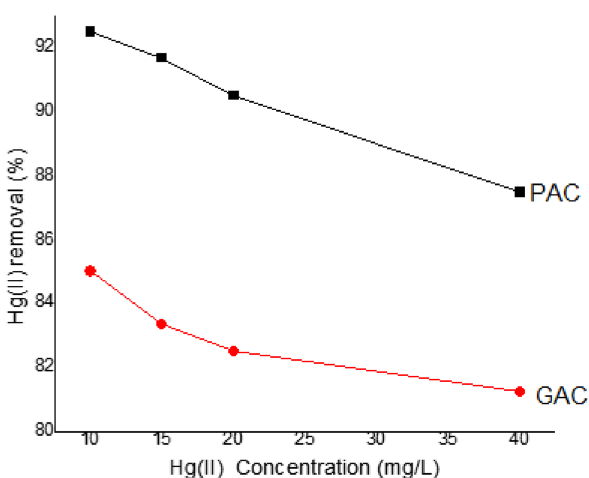
Fig. 5 A plot of adsorption capacity of PAC and GAC versus square root of contact time (min) for intra-particle diffusion